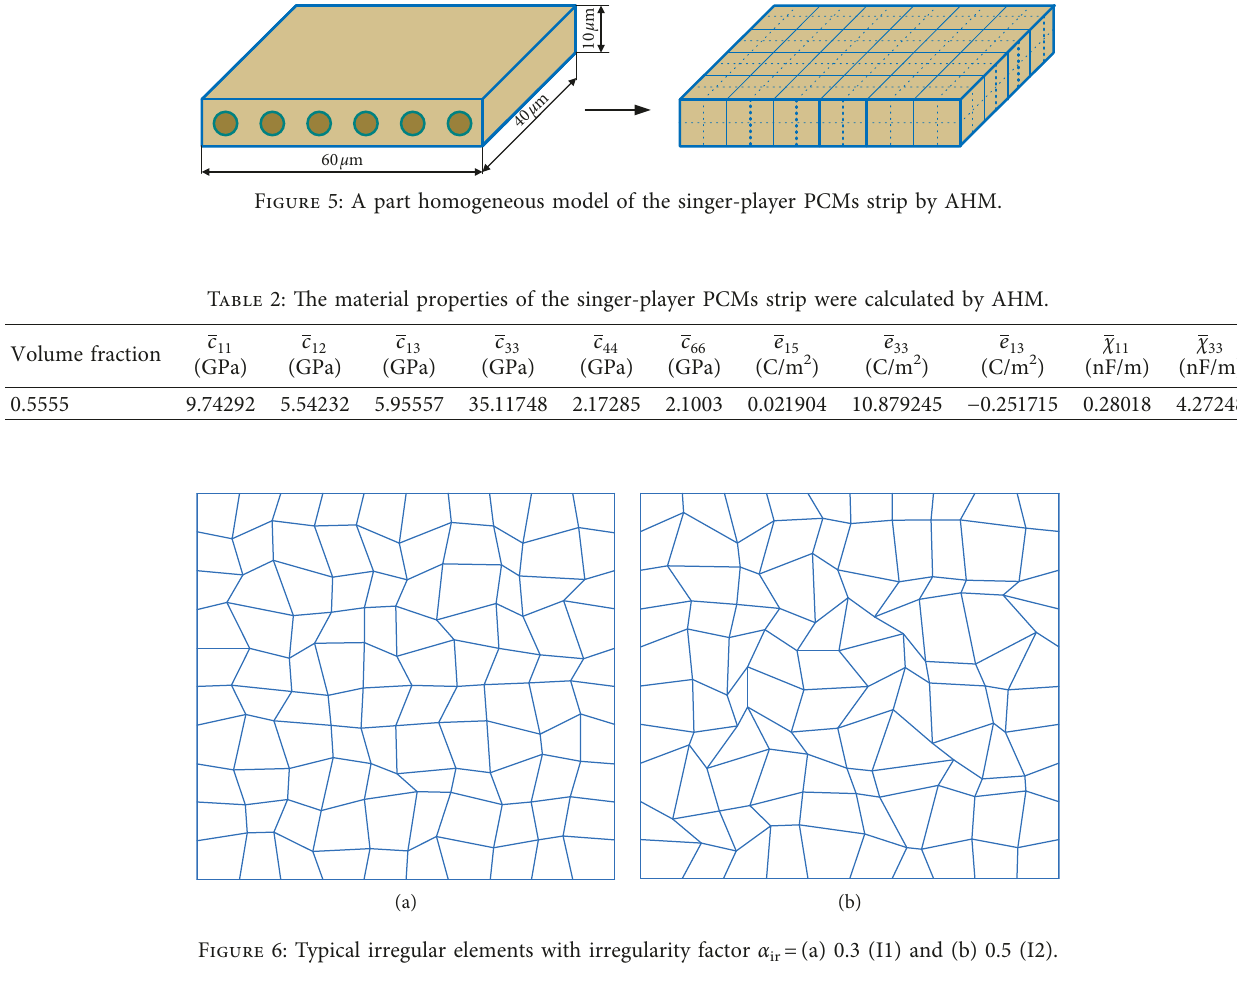
ir (cid:31) (a) 0.3 (I1) and (b) 0.5